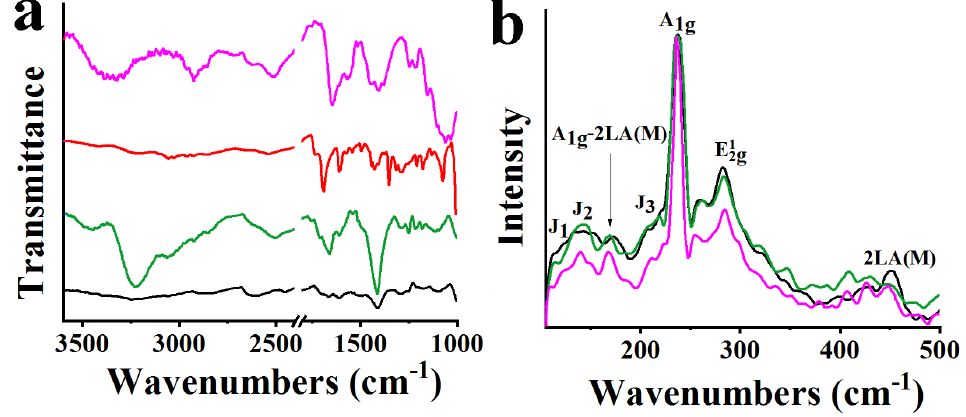
Figure 3. ( a ) ATR-IR and ( b ) Raman spectra (514 nm) for MoSe 2 -CoP (pink), MoSe 2 (black), f-MoSe 2 (green), and CoP